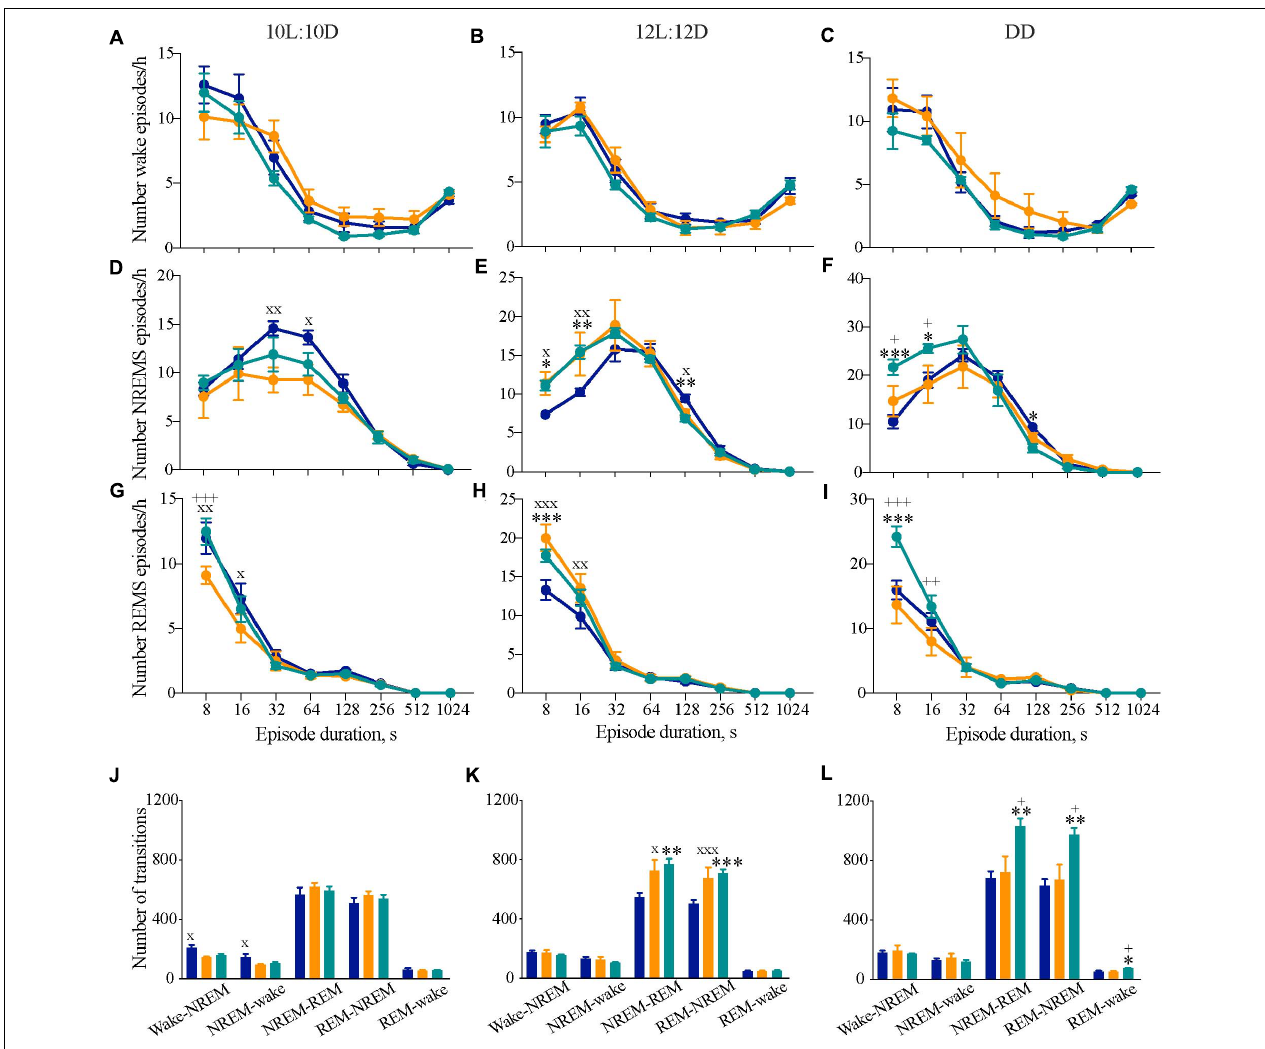
FIGURE 4 | Disrupted sleep continuity in circadian chimeric mice. (A–I) Frequency distribution (mean ± SEM) of the mean number of episodes per bin (expressed per hour of its respective vigilance state) of wakefulness (A–C) , NREM sleep (D–F) , and REM sleep (G–I) throughout consecutive time bins (8–12, 16–28, 32–60, 64–124, 128–252, 256–508, 512–1020, > 1024 s) over the entraining 10L:10D cycle (A,D,E) , 12L:12D cycle (B,E,H) and under free-running DD (C,F,I) in WT (blue, n = 6–9), Tau (orange, n = 5–7), and chimeric mice (green, n = 6–7). Values are plotted against the lower limit of each bin. (J–L) Mean number of transitions between vigilance states under entraining 10L:10D cycle (J) , 12L:12D cycle (K) , and free-running DD (L) in WT ( n = 6–9, blue), Tau ( n = 5–7, orange), and chimeric ( n = 6–7, green) mice (1xANOVA with post hoc Tukey’s multiple comparisons test, ∗ p < 0.05; ∗∗ p < 0.01; ∗∗∗ p < 0.0001 WT vs. chimera; + p < 0.05, ++ p <